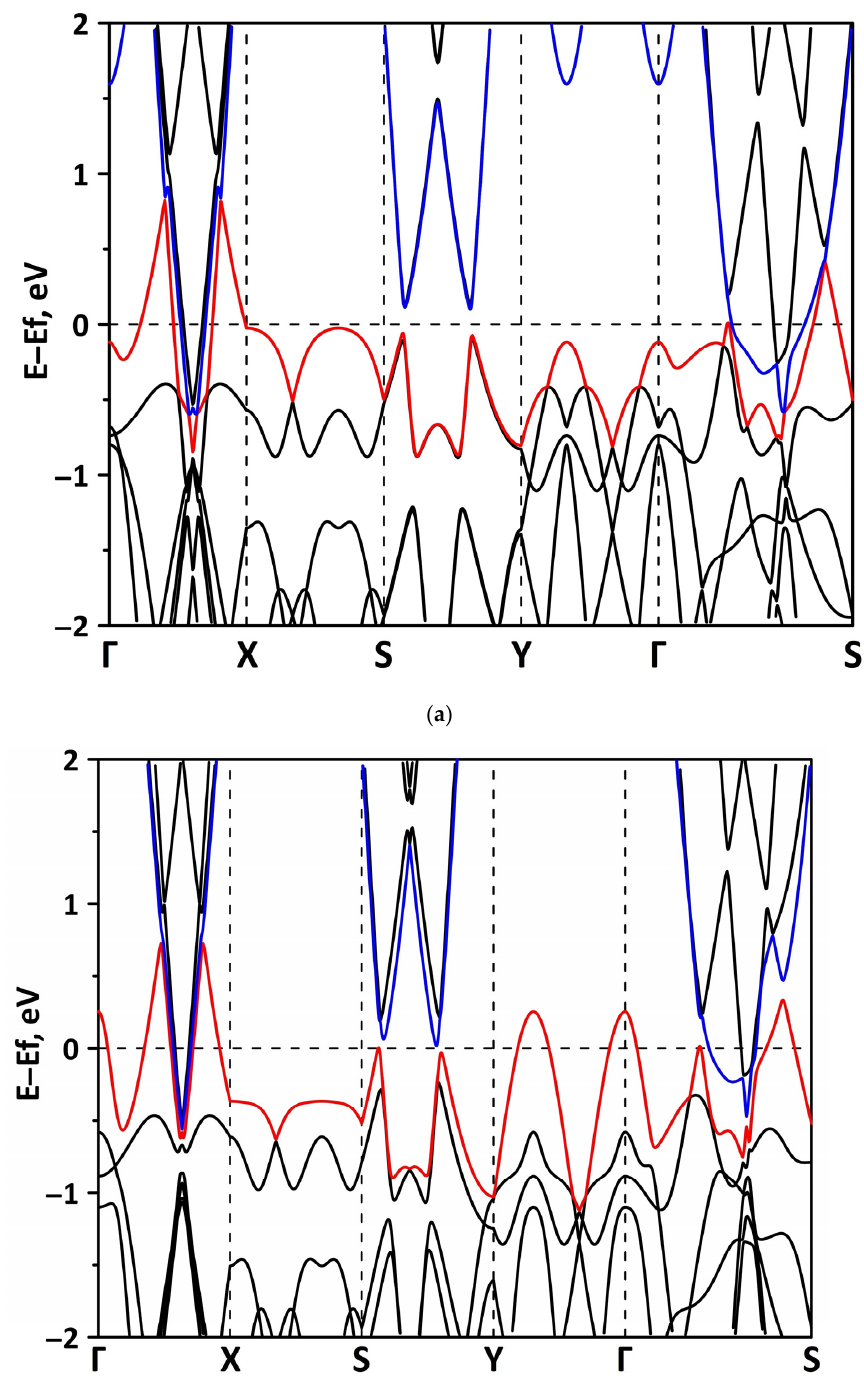
Figure 17. Fragments of the band diagrams near the Fermi level (shifted to 0 eV) of borophene/GaN heterostructure under biaxial compression by 2% ( a ) and 6% ( b ). The VBM is highlighted in red and the CBM is highlighted in blue.